Question: Reading the figure, is the described quantity rising or falling?
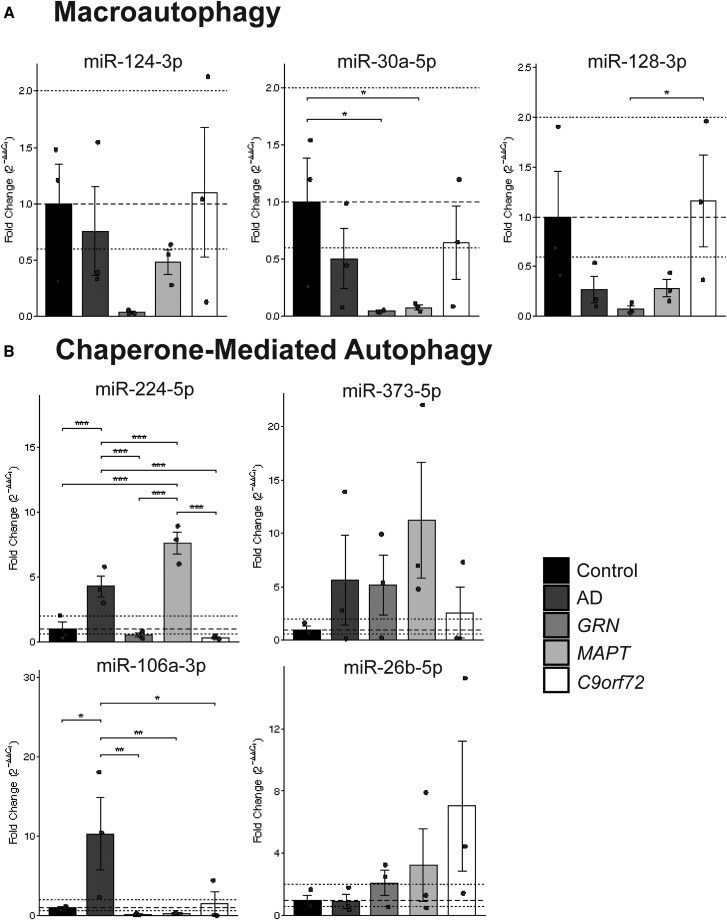
Answer: increasing